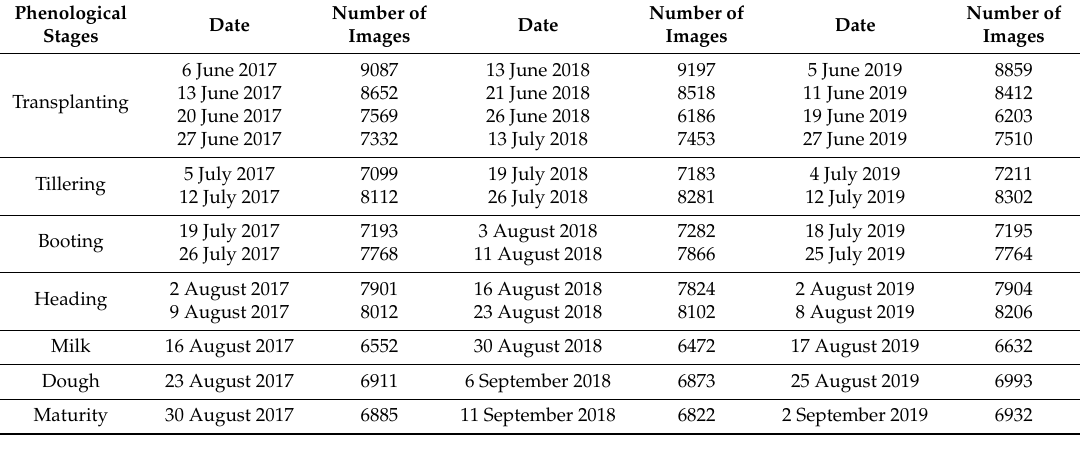
Table 3. The record of data acquisition on di ff erent dates for village 2 from 2017 to 2019.